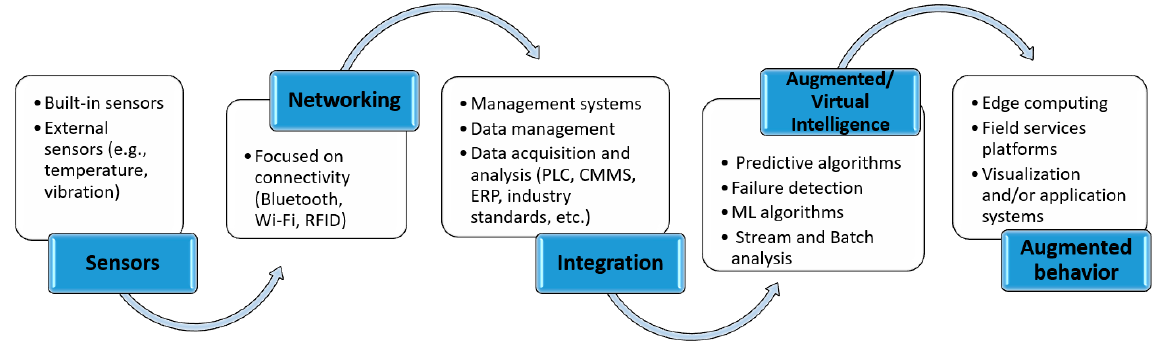
12 of 60 Figure 6. Development directions in Maintenance 4.0. Source: own contribution based on [52].